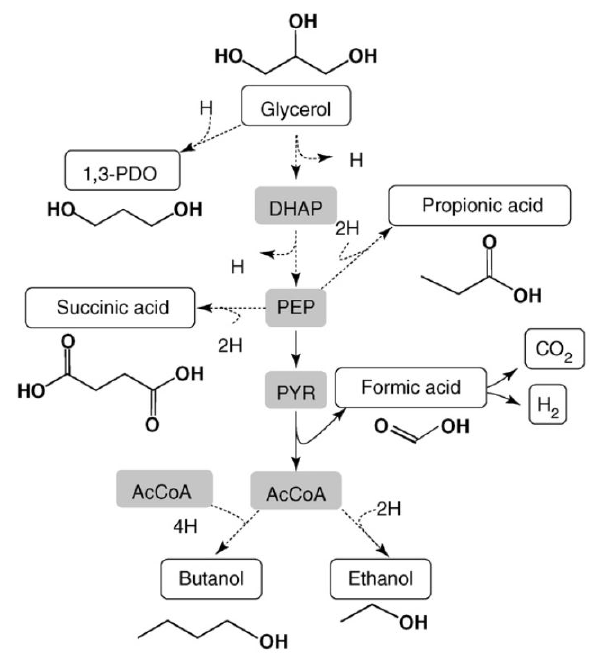
Figure 5. Examples of products synthesized from glycerol fermentation. Broken lines represent pathways composed of several reactions. (Abbreviations: AcCoA, acetyl-coenzyme A; DHAP, dihydroxyacetone phosphate; PEP, phosphoenolpyruvate; PYR, pyruvate; 1,3-PDO, 1,3-propanediol). Reprinted with permission from [105]. Copyright 2007